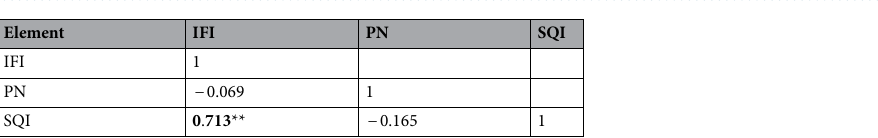
Figure 3. Spatial distribution of the integrated fertility index (IFI), Nemerow pollution index (PN) and soil quality index (SQI) in the study area (created by using ArcGIS Desktop 10.5. ESRI, California, US. https:// deskt op. arcgis. com).